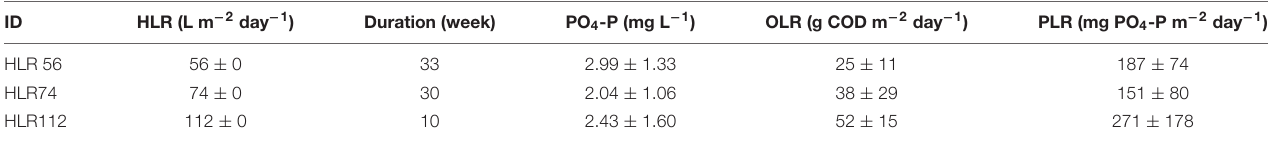
FIGURE 1 | Set-up used for the biochar column experiment [unimpregnated biochar (UBC), calcium oxide impregnated biochar (CBC), ferric chloride impregnated biochar (FBC), and biochar mixed with Polonite R (cid:13) (PBC)]. TABLE 1 | Loading conditions used during the hydraulic loading rate (HLR) trial.